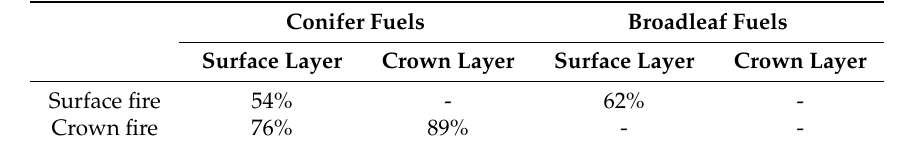
Table 1. Combustion efficiency for surface- and crown-fire carrying fuels.